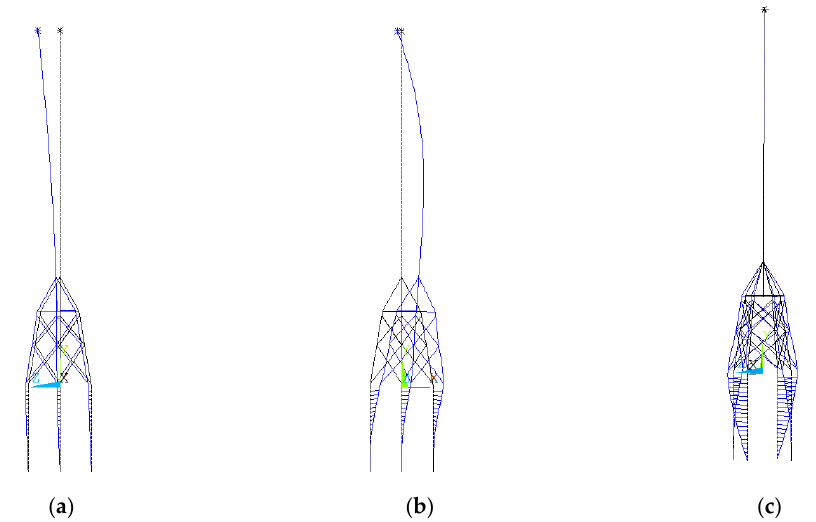
Figure 5. The first three mode shapes of the tripod structure: ( a ) frequency = 0.341 Hz, ( b ) frequency